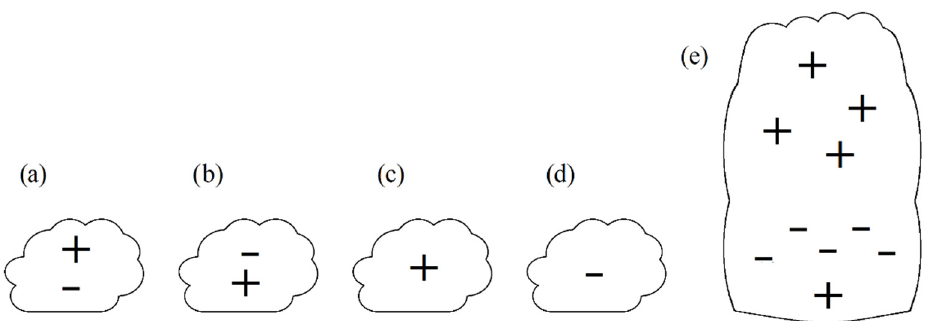
Figure 2. The schematics of basic electrical structures encountered in horizontal layered clouds: ( a ) positive polarization, ( b ) negative polarization, ( c ) total positive charge, ( d ) total negative charge, and ( e ) for comparison—electrical structure of a towering vertical storm cloud.